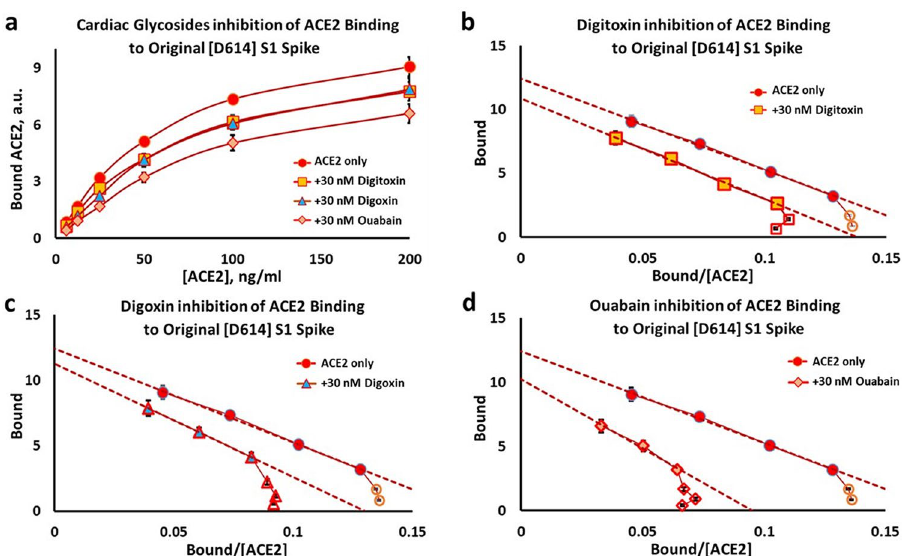
Figure 5. Inhibition of ACE binding to the Original [D614] S1 spike by cardiac glycoside drugs. ( a ) Substrate- Binding plots for inhibition by digitoxin, digoxin and ouabain (30 nM). ( b – d ) Eadie–Hoffstee plots of data in Part ( a ) for digitoxin inhibition ( b ), digoxin inhibition ( c ), and ouabain inhibition ( d ). Each point is the average ± SE for N = 5–6 independent